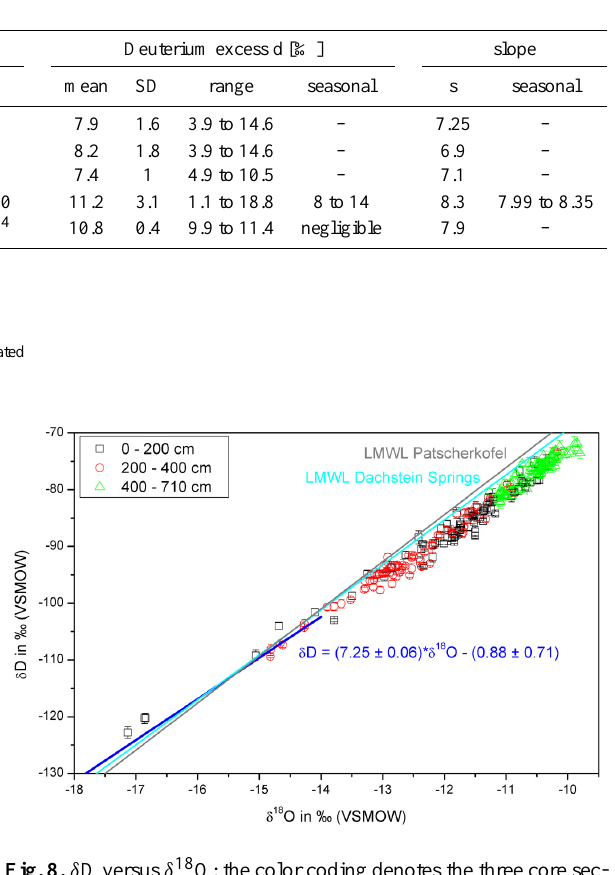
Table 3. Statistical data of δ 18 O and Deuterium excess d, including mean values, standard deviation, max./min. range and seasonal range, as well as slope s and its seasonal range in the ERW ice core, at the Patscherkofel site and 12 springs in the Dachstein area.